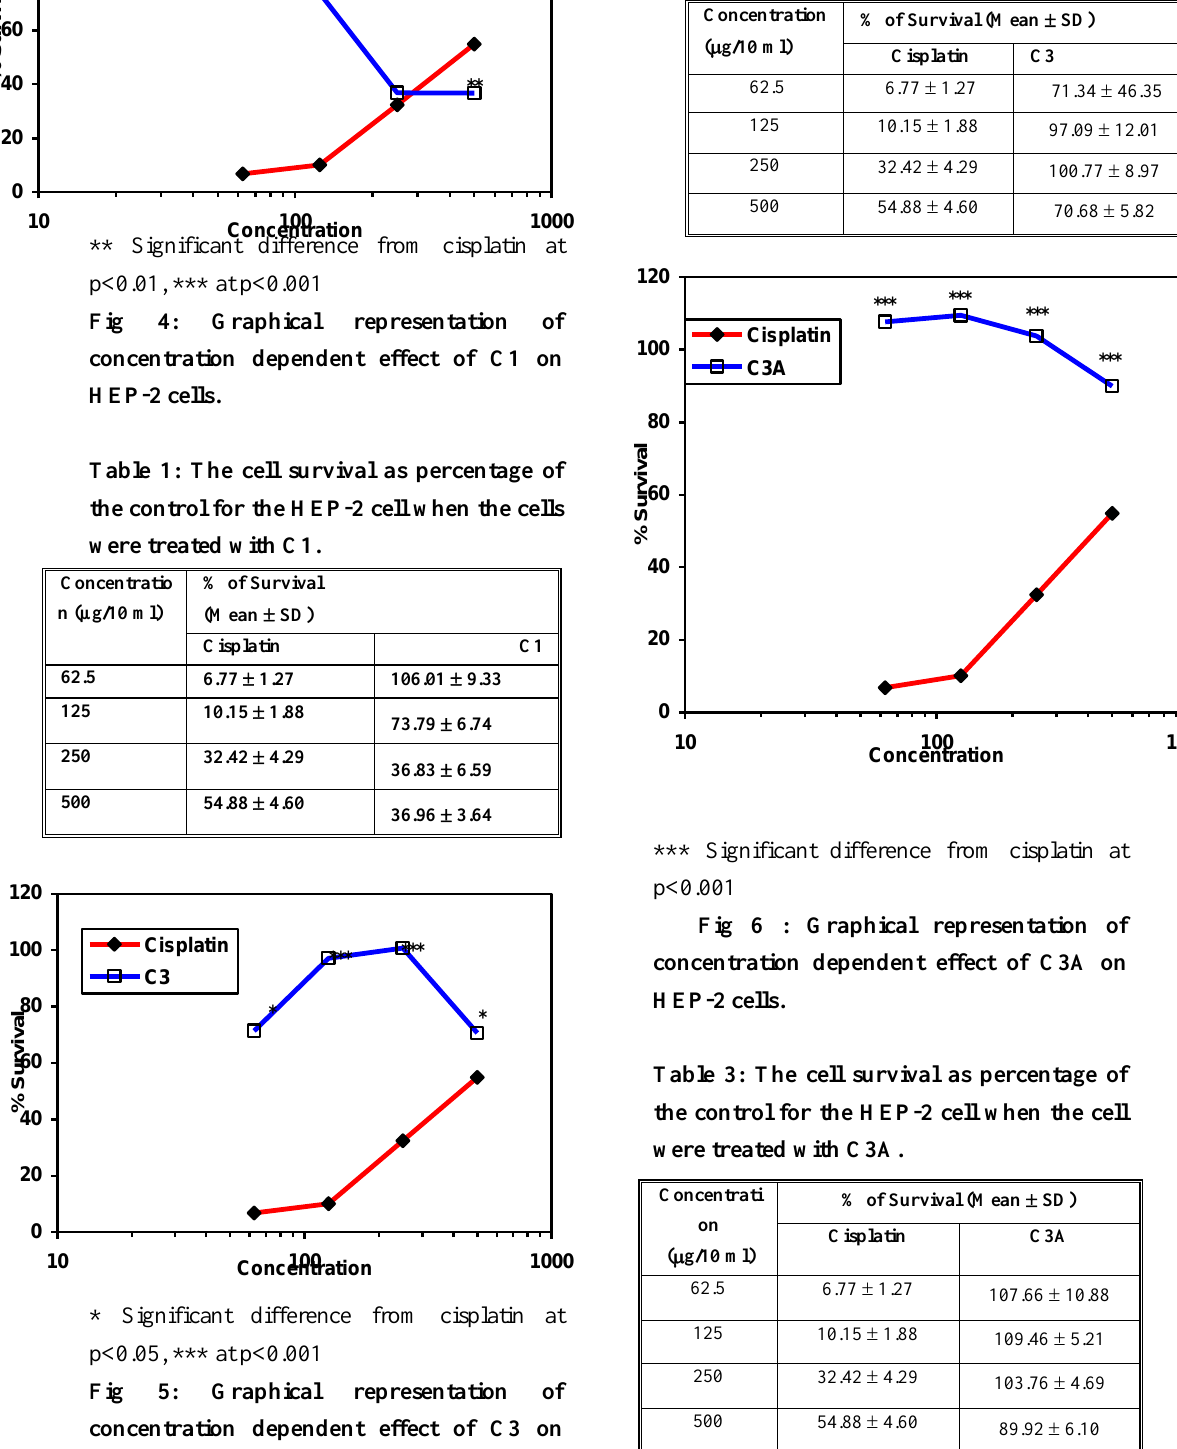
Table 2: the cell survival as percentage of the control for the HEP-2 cell when the cell were treated with C3.